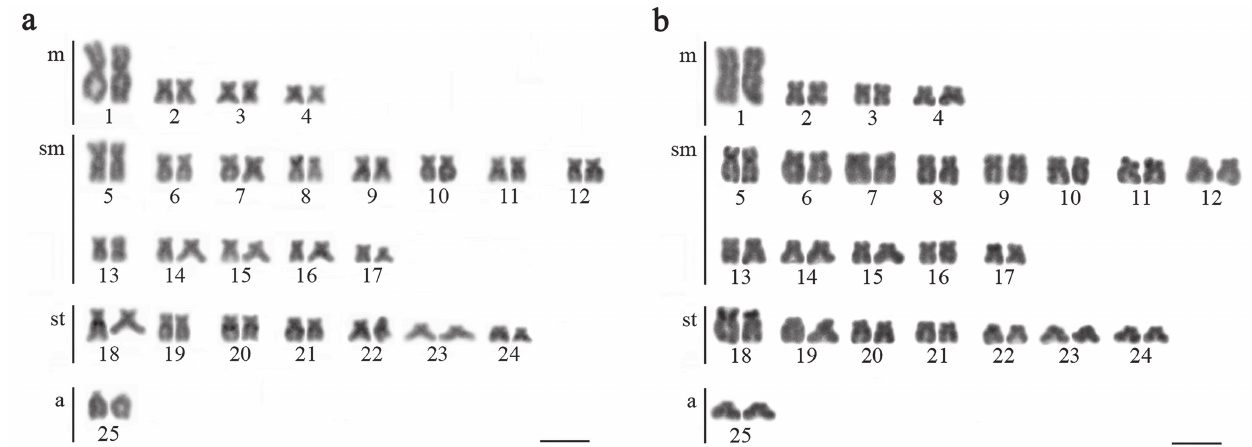
Fig. 3. Representative C-banded karyotypes of Nematocharax venustus from (a) Almada, Gongogi 1, Gongogi 2, Gongogi 3, Jequitinhonha 1, Jequitinhonha 2 and (b) Upper Contas. Bar = 5 µm.